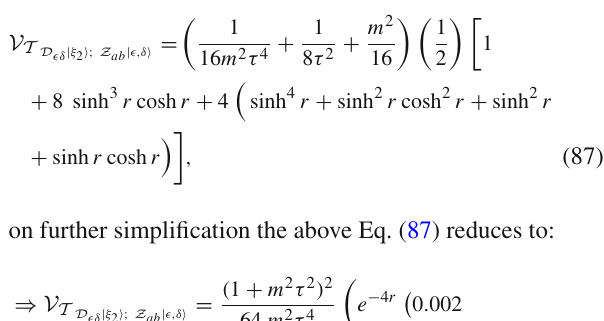
Fig. 8 a , b are the plots for the density fluctuations and dimensionless quantity in TMCS and TMSC states, plotted as a function of squeezing parameter r . Note that the two states are semiclassical states with V T close to zero and D T (cid:10) 1 only when r (cid:10) 1, otherwise the states are very